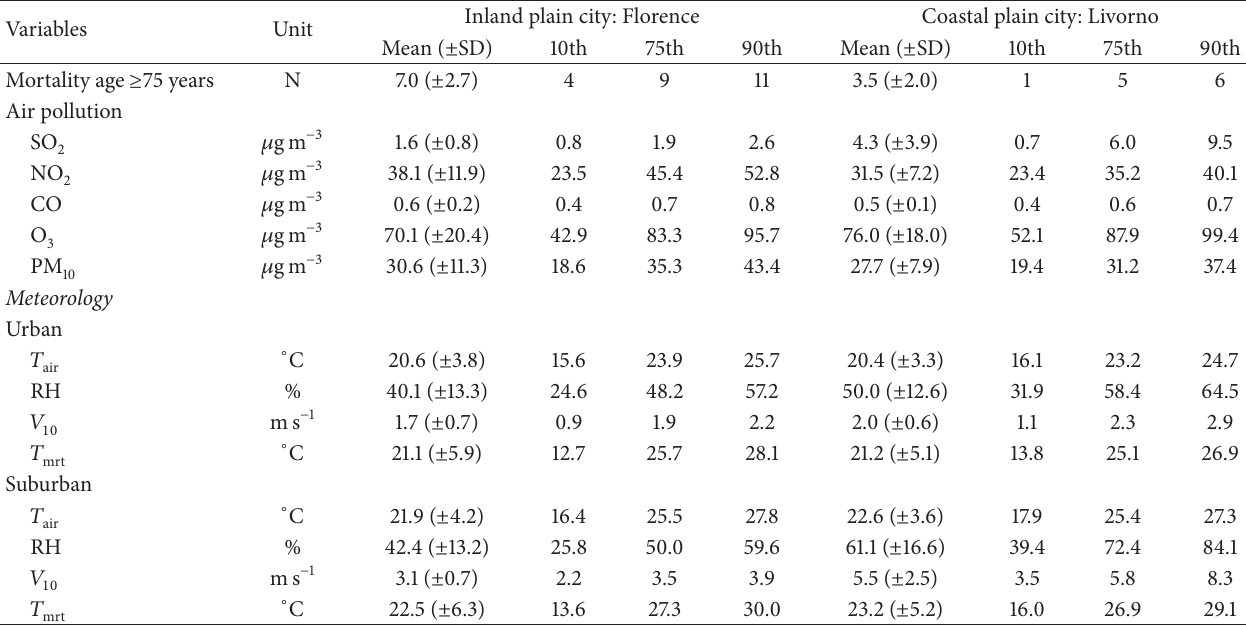
Table 1: Descriptive statistics for daily all-cause mortality of the very elderly (subjects ≥ 75 years of age), air pollution, and meteorological parameters measured in urban and suburban areas of Florence and Livorno during the warmest period of the year (May–October) from 2006 to 2008. Mean, standard deviation (SD), and 10th, 75th, and 90th percentiles are shown. Inland plain city: Florence Coastal plain city: Livorno Variables Unit Mean ( ± SD) 10th